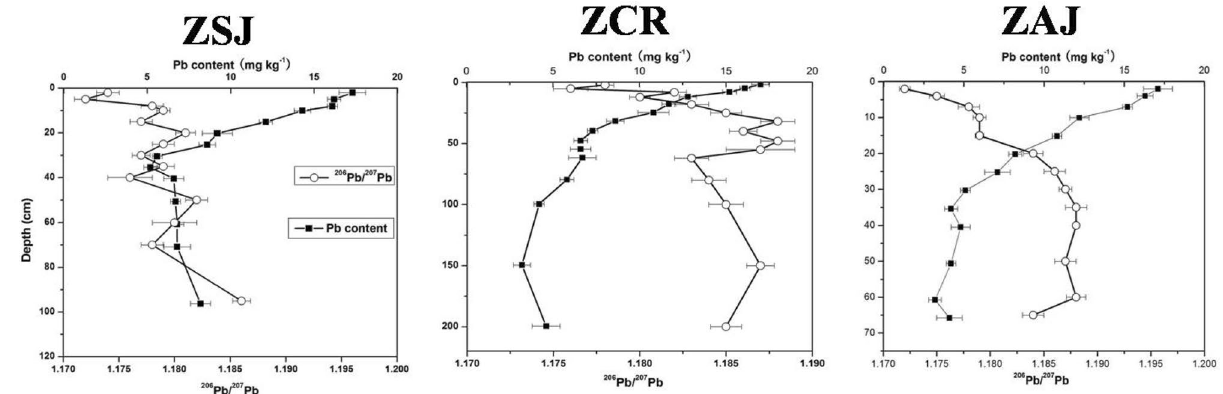
Figure 2. 208 Pb/ 206 Pb vs. 206 Pb/ 207 Pb ratios. The ZSJ, ZCR and ZAJ soil profiles were represented for Sanjie, Chongren and Anjishan of Zhejiang province,